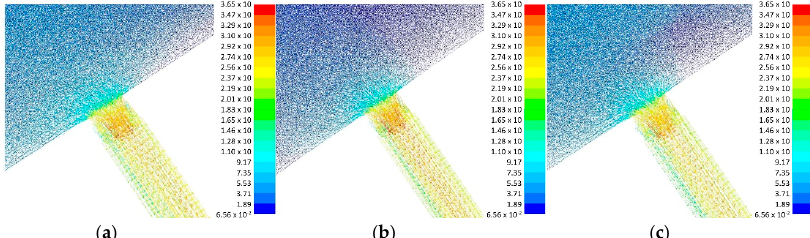
Figure 13. Velocity field for circular orifice at P = 5.0 bar and Q in = ( a ) 10 L/s, ( b ) 20 L/s, ( c ) 30 L/s.